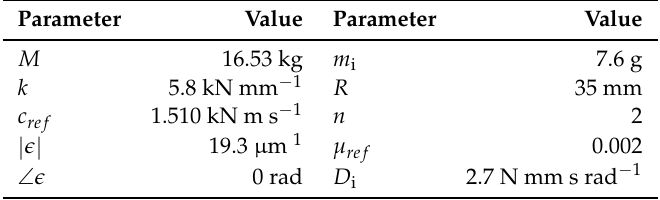
Table 1. Nominal parameter values of the Automatic Ball Balancer (ABB)—Jeffcott rotor model.